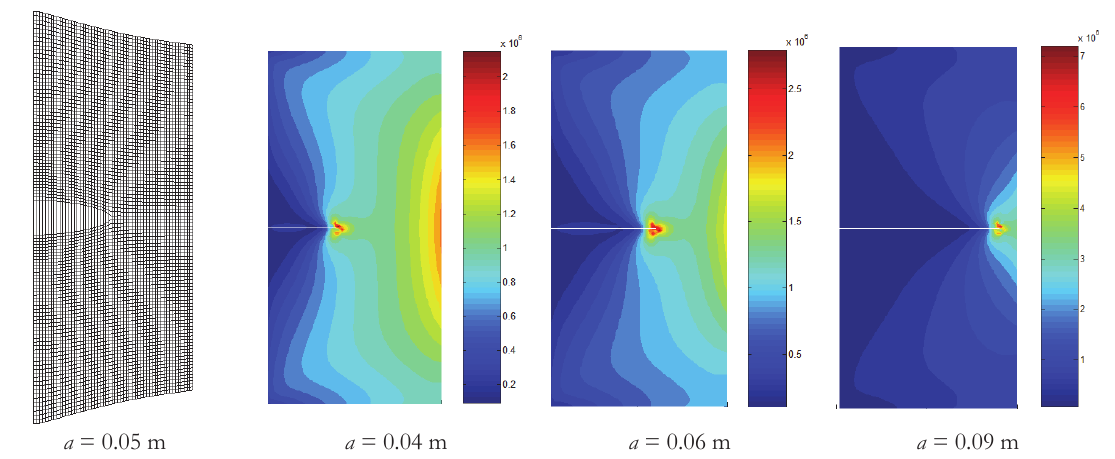
Figure 5: Deformed mesh and von Mises stress contours for the axisymmetric cross sections with various crack length.